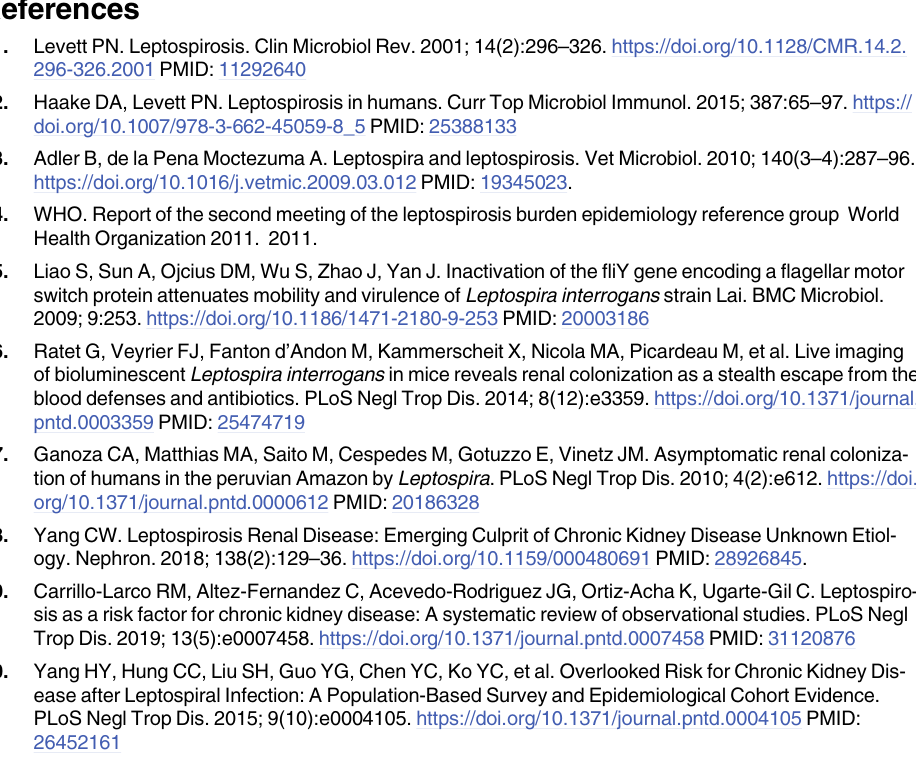
S1 Fig. Storage period and atrophic tubules score. The atrophic tubules scores were com- pared between hamsters injected with Leptospira of storage period for less than 1 month (n = 4) and storage period for over 1 month (n = 8). The average value for each group is indi- cated by a